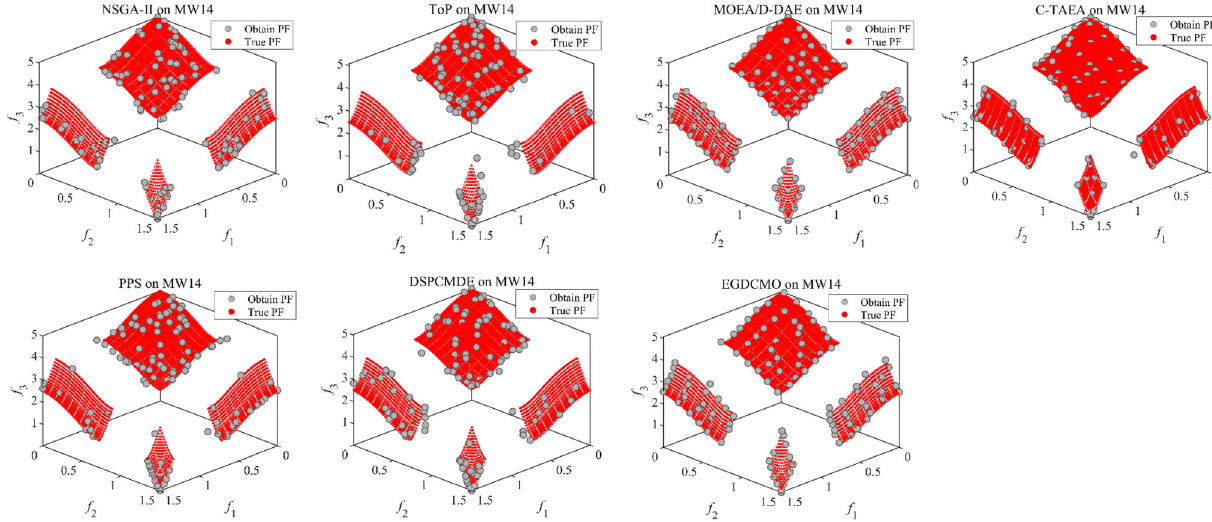
Fig. 13 Pareto front with median IGD value obtained by the proposed EGDCMO and all the compared CMOEAs on MW14